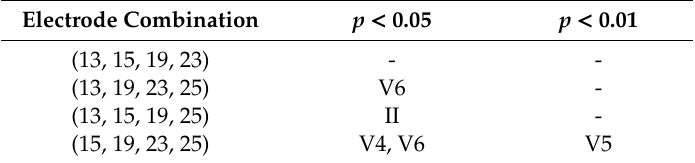
Figure 7. Reconstruction quality when considering the robustness of position: ( a ) colored map obtained by using the mean CC value, ( b ) colored map obtained by using the min CC value, and ( c ) reconstruction quality of the 60 triangular shapes according to the electrode position. The red-dotted line indicates the suggested position. Table 6. P -values of the ANOVA analysis of the CCs for di ff erent orientations of the triangular